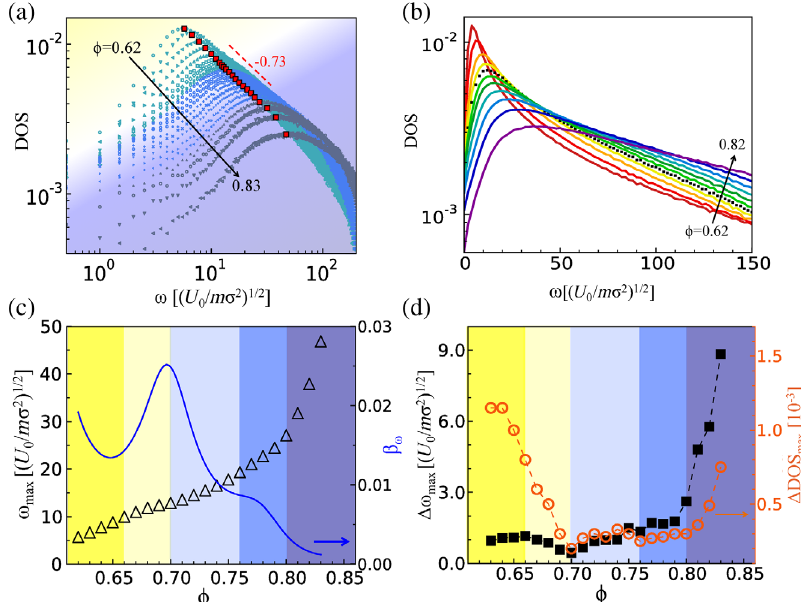
∼ ω − 0 . 73 FIG. 5. (a) The DOS peaks (red squares) follow the relation DOS . (b) In the semilog plot of DOS, the tail is convex in the max max polycrystal regime, convex in the glass regime, and straight at the crystal-glass boundary ϕ ¼ 0 . 70 (black symbols). (c) The frequency of the DOS peak, ω (triangles), has a similar shape to P ð ϕ Þ in Fig. 3(a). β ω ≡ ϕ − 1 d ϕ =d ω (blue curve) has a similar shape to that of the max compressibility in Fig. 3(a). (d) The step size Δ DOS (circles) and Δ ω (squares) between neighboring max max